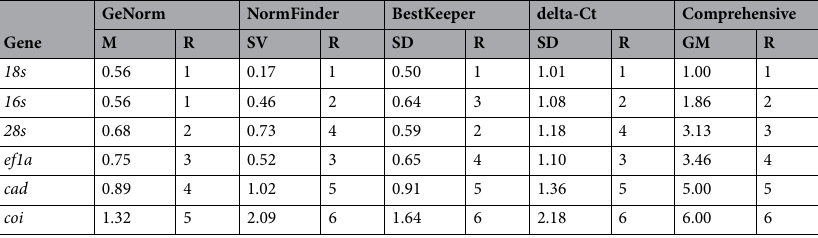
Table 1. Stability rankings of the 6 candidate reference genes using RefFinder: GeNorm, NormFinder, BestKeeper, delta-CT, and a comprehensive rank from RefFinder. R: ranking; M: gene expression stability; SV: stability value; SD: standard deviation; GM: geomean